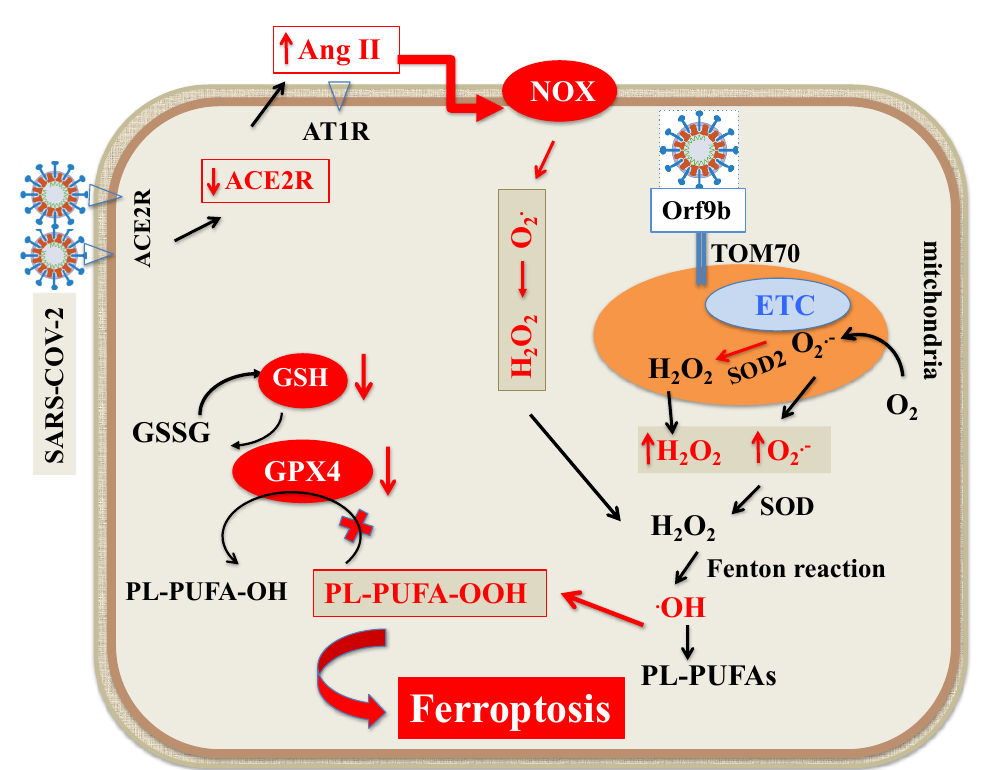
Figure 3. Scheme of ROS generation during SARS-CoV-2 infection. The main cellular sources of ROS are mitochondria and NOX at the cell membrane. O 2 •− is produced by ETC on the internal membrane of the mitochondria. Subsequently, O 2 •− and H 2 O 2 produced by mitochondrial SOD2 can propagate from mitochondria to the cytosol. The migrated O 2 •− is converted to further H 2 O 2 by SOD and eventually, by Fenton reaction, transformed into · OH, triggering LOOH generation from PUFAs. In addition, Orf9b, one of the accessory proteins of SARS-CoV-2 increases ROS generation by binding to TOM70 at the surface of mitochondria membrane. As for NOX, SARS-CoV-2 by downregulating ACE2 receptors increases circulating Ang II and its binding to AT1R, which, by triggering NOX, increases ROS formation. Abbreviations: ACE2R: angiotensin converting enzyme 2 receptor; Ang II: angiotensin II; AT1R: angiotensin 1 receptor; ETC: electron transport chain; H 2 O 2 : hydrogen peroxide; LOOH: peroxides; NOX: nicotinamide adenine dinucleotide phosphate oxidase; O 2 ● − : superoxide; ● OH: hydroxyl radical; Orf9B: open reading frame-9b; PUFAs: polyunsaturated fatty acids; PL-PUFA: phos- pholipid polyunsaturated fatty acids; PUFA-OH: phospholipid polyunsaturated fatty acid alcohols; PL-PUFA-OOH: phospholipid polyunsaturated fatty acid peroxides; ROS: reactive oxygen species; SOD: superoxide dismutase; TOM70: translocase of outer membrane 70.